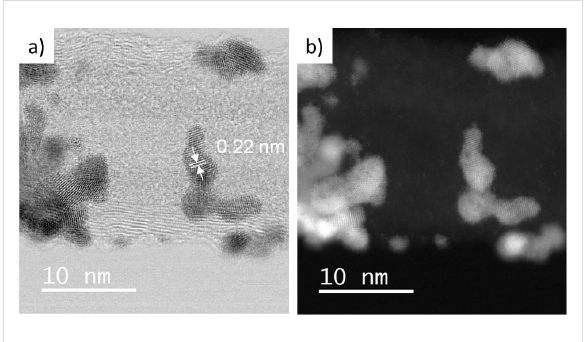
Figure 9: a) HRTEM images of Pt 3 Co/N-CNT and b) STEM-HAADF image of Pt 3 Co/N-CNT after washing with